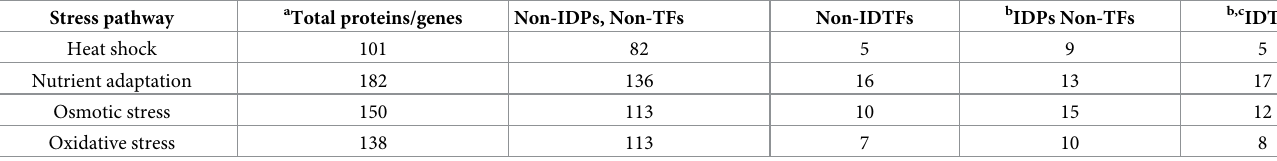
The osmotic stress response signaling pathway is one of the best characterized in S . cerevisiae , due by the fact that this yeast thrives in a natural habitat where sugars could reach high con- centrations [48, 49]. To cope with such osmolarity increase, yeast induce a diversity of adaptive Table 2. Distribution of yeast ordered proteins and IDPs involved in stress responses.